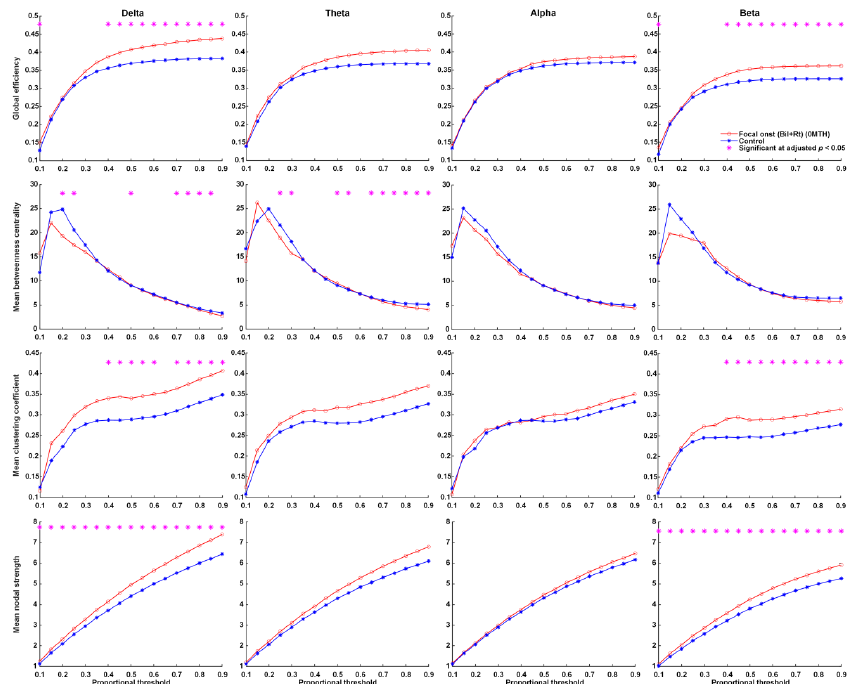
Figure 1. Parameters related to graph theory-based electroencephalographic connectivity in patients with FOS presenting right or bilateral EEG lateralization at initiation and age-matched controls. Asterisks denote statistically significant differences (* adjusted p < 0.05).